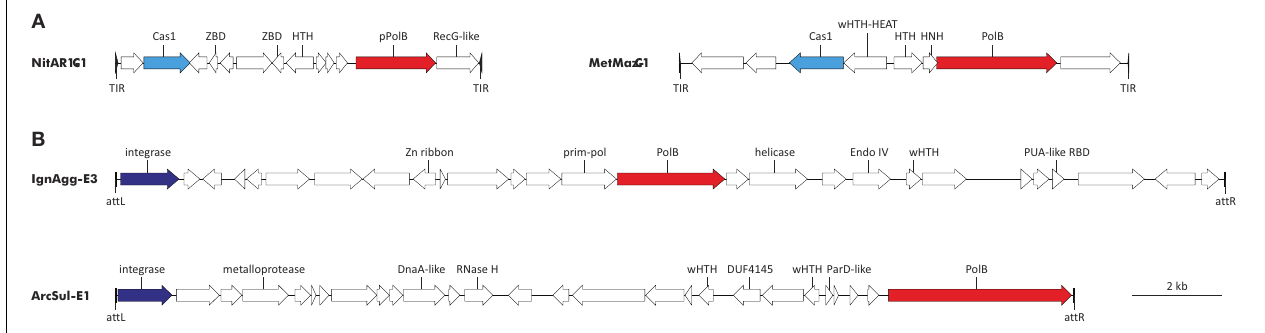
Archaeoglobus sulfaticallidus PM70-1 (NC_021169; nucleotide coordinates: 873590 to 894826). Predicted protein-coding genes are indicated with arrows, indicating the direction of transcription. Genes for PolBs are shown in red, cas1 genes are in cyan, and genes for tyrosine recombinases are colored blue. Abbreviations: TIR, terminal inverted repeats; att, attachment site; ZBD, Zinc-binding domain-containing